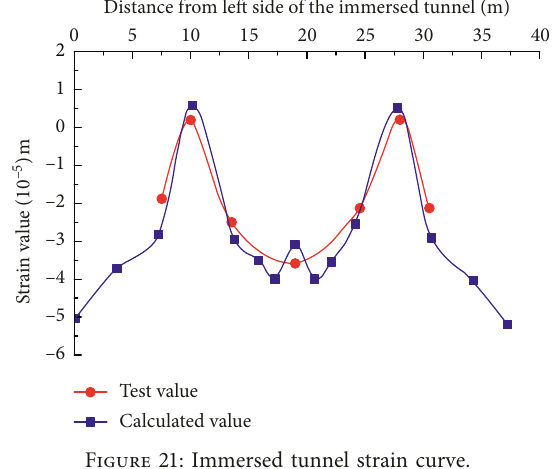
Figure 20: Transverse stress distribution curve of base. Distance from left side of the immersed tunnel (m)